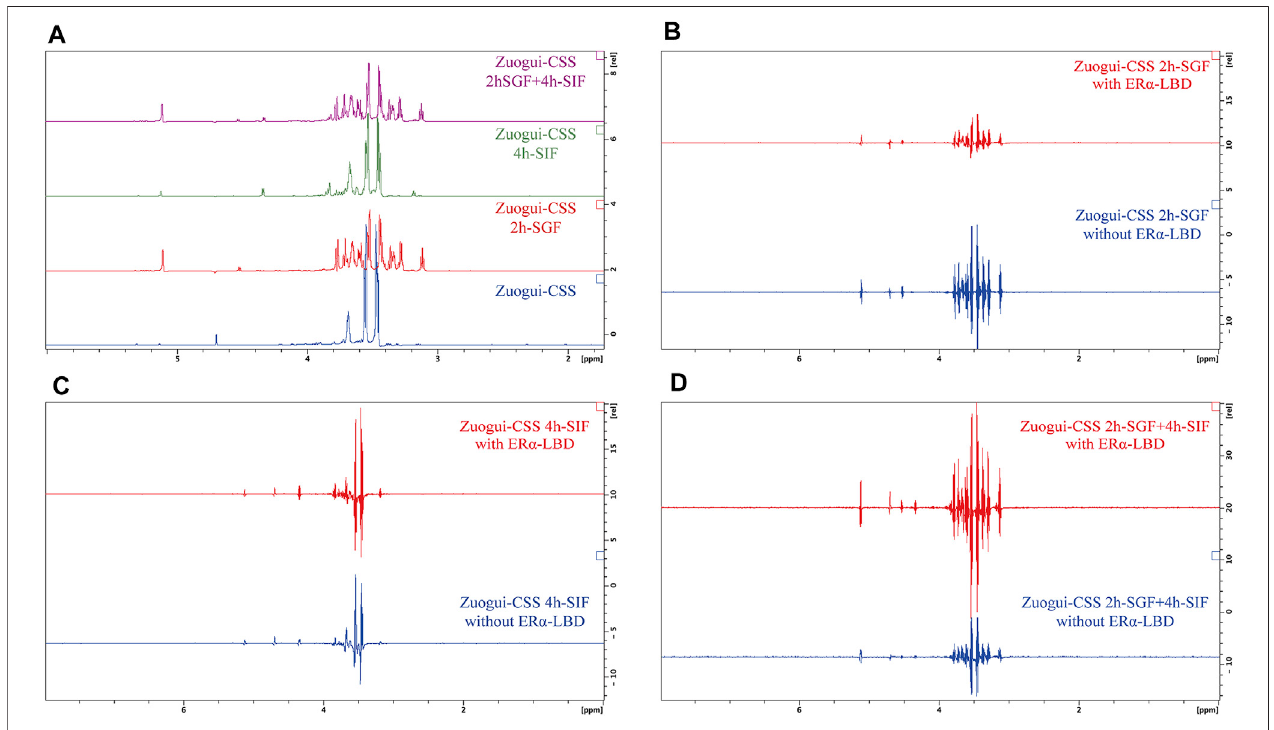
FIGURE 9 | Gastrointestinal digestion of Zuogui-CSS produced no estrogenic compound. (A) 1 H NMR spectra of Zuogui-CSS treated with simulated gastrointestinal fl uids.The blue-coloredspectrumwasfor Zuogui-CSS withoutthe treatment. Thegreen-colored spectrum wasfor Zuogui-CSS treated withSIF for4 h. Thered-coloredspectrumwasforZuogui-CSStreatedwithSGFfor2 h.Thepurple-coloredspectrumwasforZuogui-CSSsequentiallytreatedwithSGFfor2 handSIF for4 h.Peaksfornewcompoundsappearedafter Zuogui-CSSwastreatedwitheither SGF,SIF, orboth. (B) TheSTDspectraofZuogui-CSStreated withSGFfor 2 h. The upper red-colored spectrum was from the sample with ER α -LBD and the lower blue-colored spectrum was from the sample without ER α -LBD. (C) The STD spectraofZuogui-CSStreatedwithSIFfor4 h.Theupperred-coloredspectrum wasfromthesamplewithER α -LBDandthelowerblue-coloredspectrumwasfromthe sample without ER α -LBD. (D) The spectra of Zuogui-CSS were treated sequentially with SGF for 2 h and SIF for 4 h. The upper red-colored spectrum was from the samplewithER α -LBD andthelowerblue-coloredspectrum wasfrom thesamplewithoutER α -LBD. TheSTDspectrawerewithonlysolventsignalpeaks(e.g.,glycerol, H 2 O, and self-degradation products of pepsin or pancreatin). There was no indication of any compound that could interact with ER α